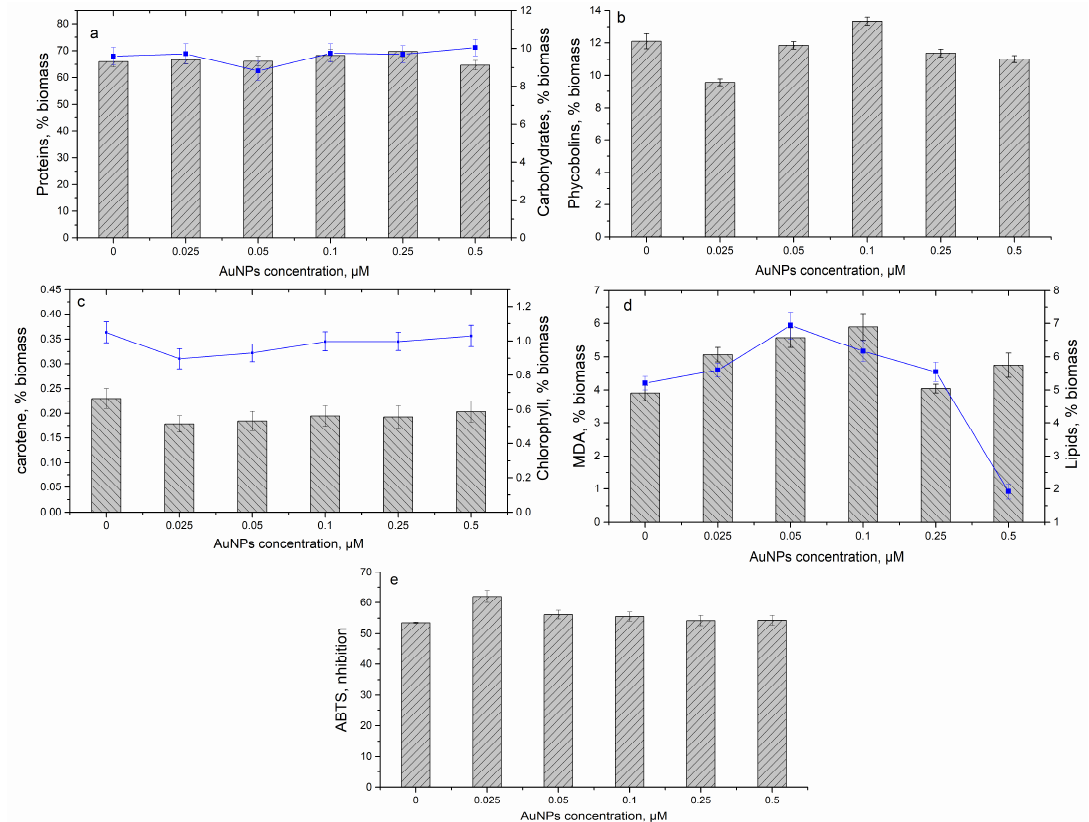
Figure 6. Change of ( a ) proteins and carbohydrates, ( b ) phycobilins, ( c ) β-carotene and chlorophyll a, ( d ) lipids and MDA content, and ( e ) antioxidant activity of hydric extract in Spirulina platensis biomass at the introduction of AuNPs in cultivation medium in concentration range 0.025–0.1 µM.